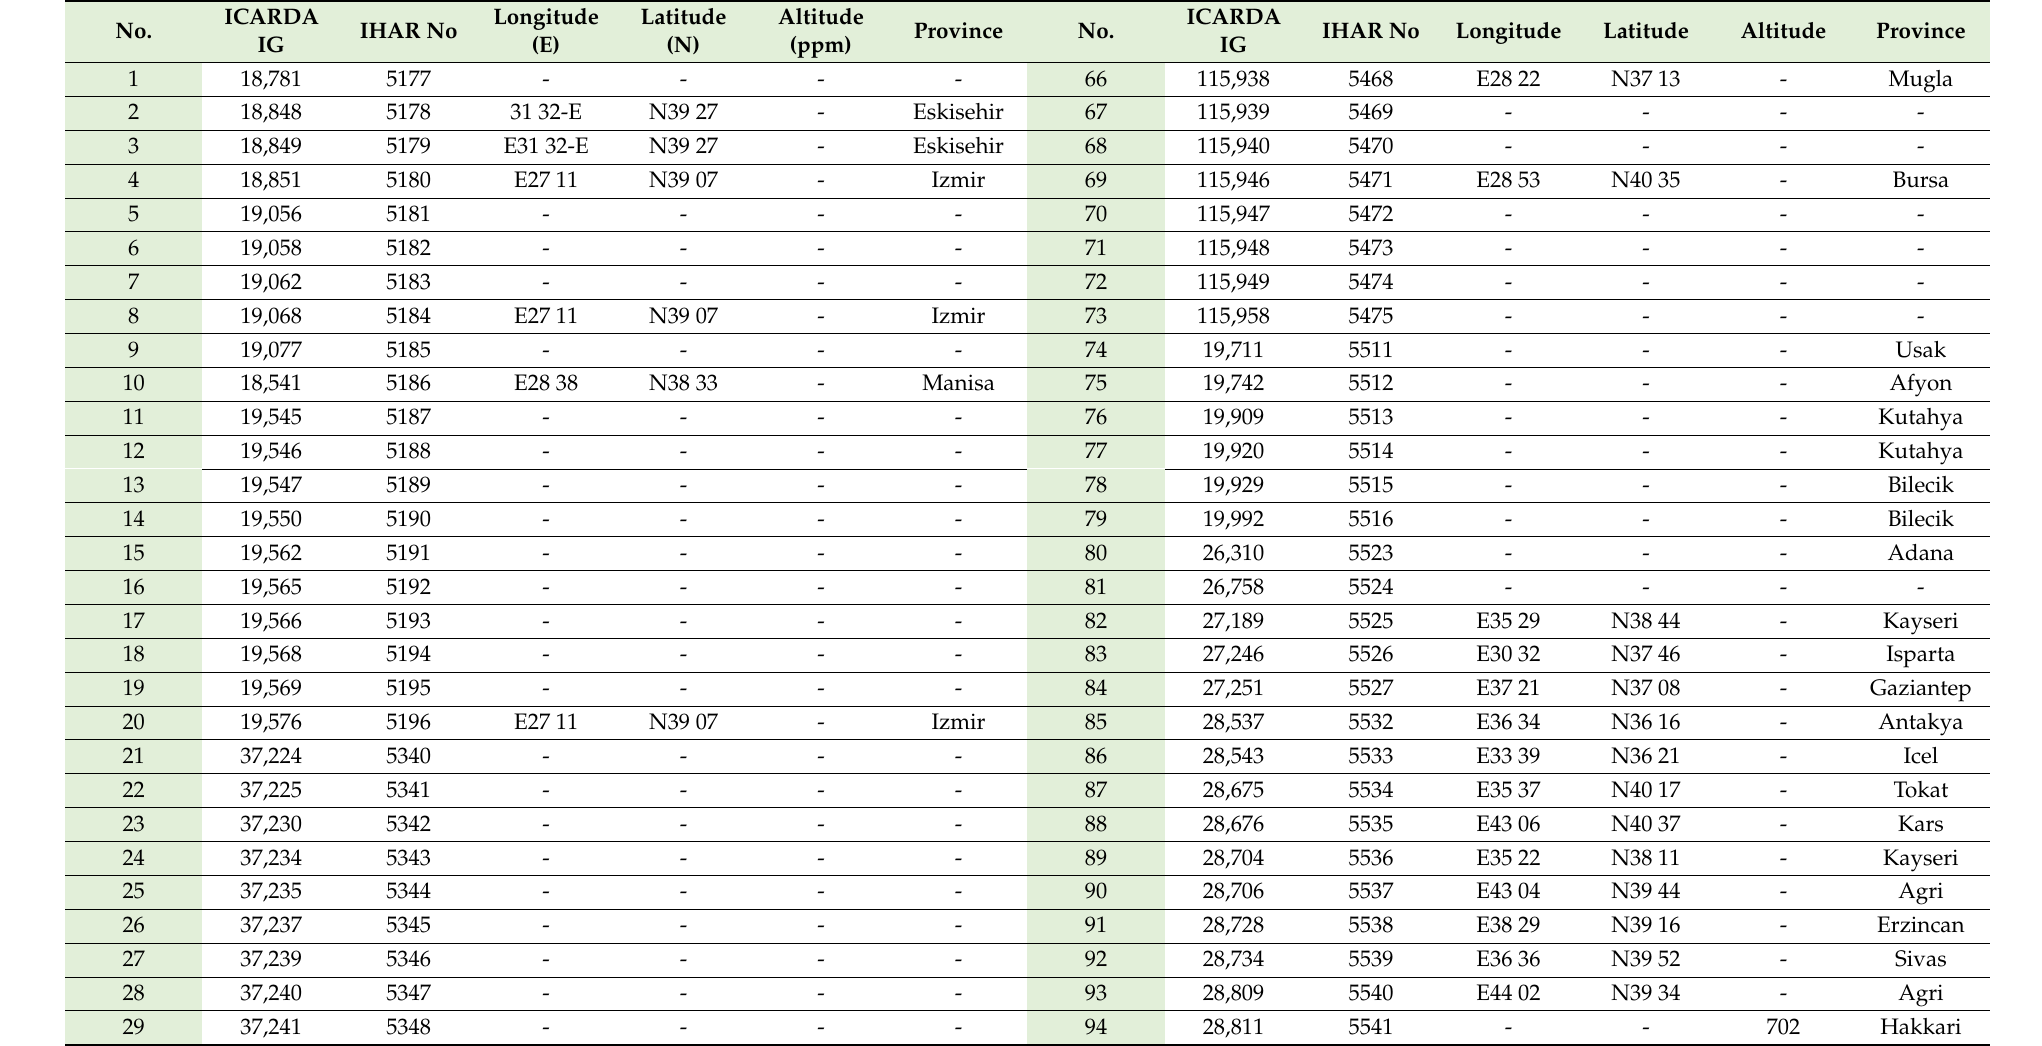
Table 1. Collected data of 129 landraces from